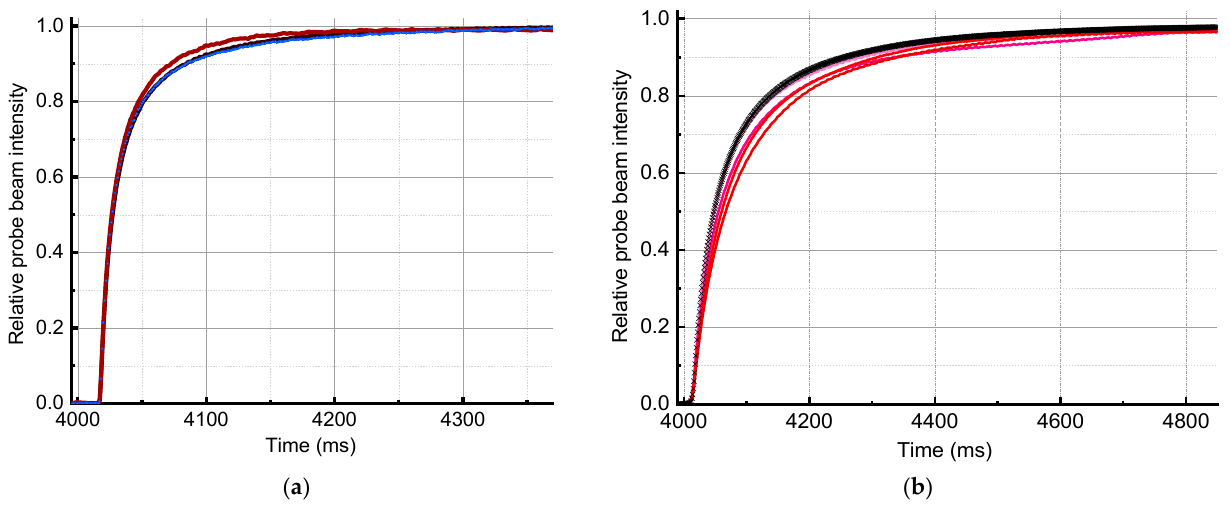
Figure 12. Normalized averaged transient thermal-lens dissipation curves ( a ) for water (light blue symbols) and aqueous colloidal solutions of TM-50 silicon oxide (1.6 and 3.1% v / v , black and red lines, respectively). The greater the concentration of nanoparticles, the faster the cooling of the solution. ( b ) For aqueous dispersions of RUDDM nanodiamonds at concentrations of 1.0, 1.5, 2.0, and 2.5 mg/mL (light pink, pink, red, and burgundy lines, respectively) and for water (black symbols). Heating time, 4 s. The greater the concentration of nanodiamonds, the slower the cooling of the solution after turning off the excitation laser. Setup, TLS-60; excitation wavelength, 532.0 nm; excitation power, 20 mW. The delay of the dissipation start is caused by closing the mechanical shutter.